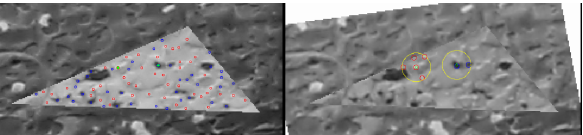
Figure 9. Potential matching region (yellow circle in secondaire image ROI - right) and possible match candidates (same caracteristic point: max (red), min (blue)) correspondent with considered interest point in master image (left- green) After matching all interest points in the ROI of master image, a spatial filter is applied to homogenize tie point distribution.